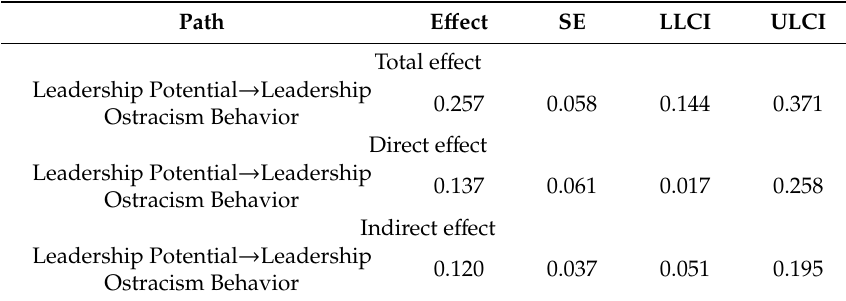
Table 8. The results of the mediating e ff ect for leader’s envy.